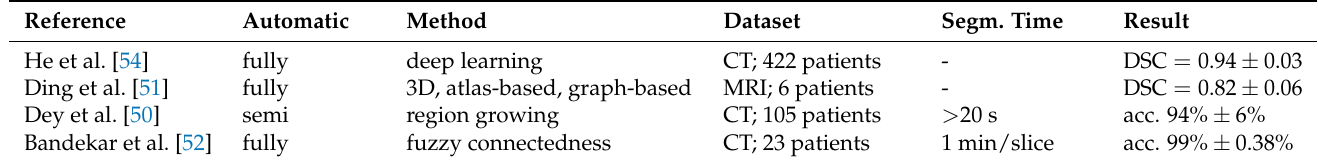
Table 1. Pericardial adipose tissue segmentation methods. DSC is the reported Dice coefficient. Segmentation time is the reported time to segment a single CT scan, unless specified